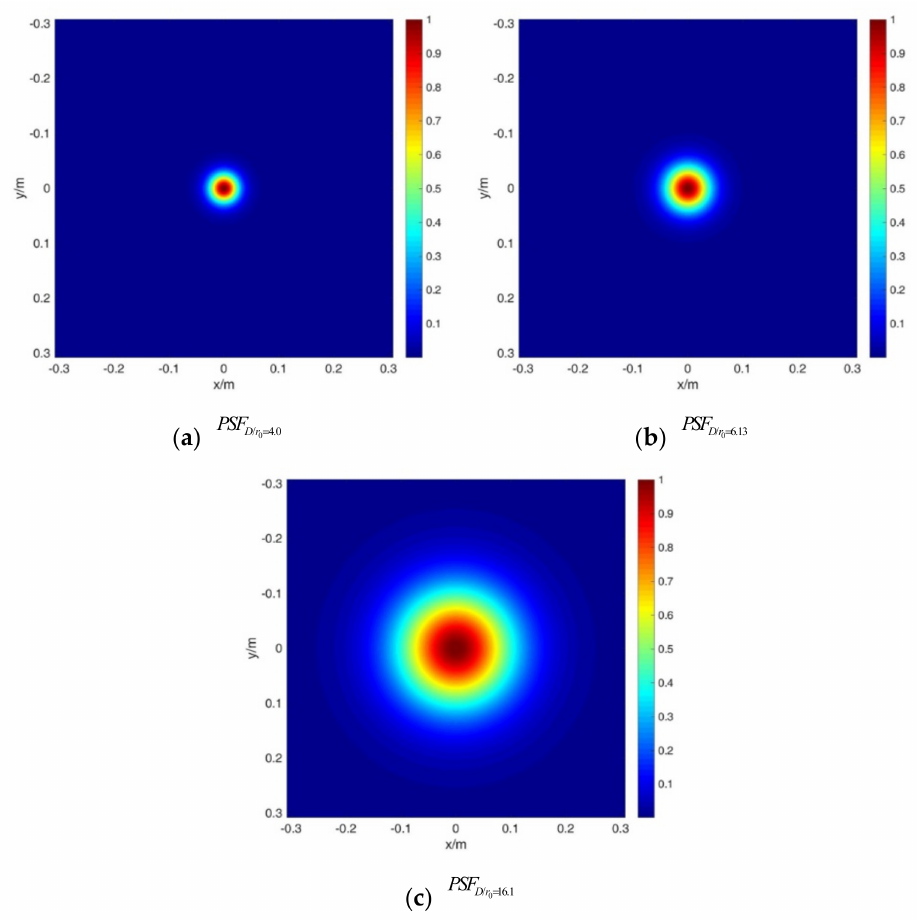
Figure 3. The PSF results for ( a ) D / r 0 = 4.0, ( b ) D / r 0 = 6.13, and ( c ) D / r 0 = 16.1.